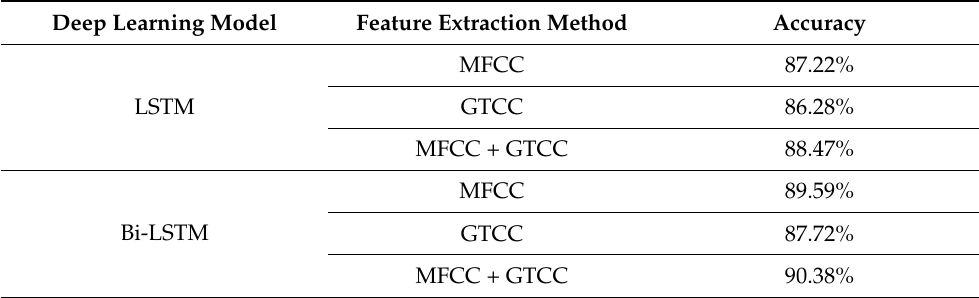
Table 3. Accuracy of 1D spectrum feature-based LSTM and Bi-LSTM models.